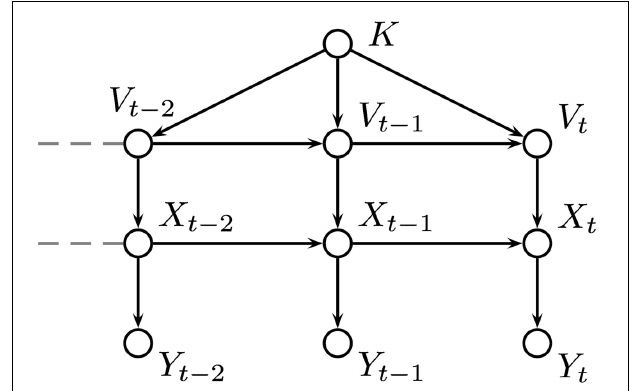
FIGURE 9 | Graphical representation of our VOL model based on the work of Behrens et al. (2007). The variable, X represents the probability of a type 2 response being rewarded and the volatility, V determines the probability of X taking a value unrelated to its current one. The parameter, K is a measure of trust in the estimated value of the